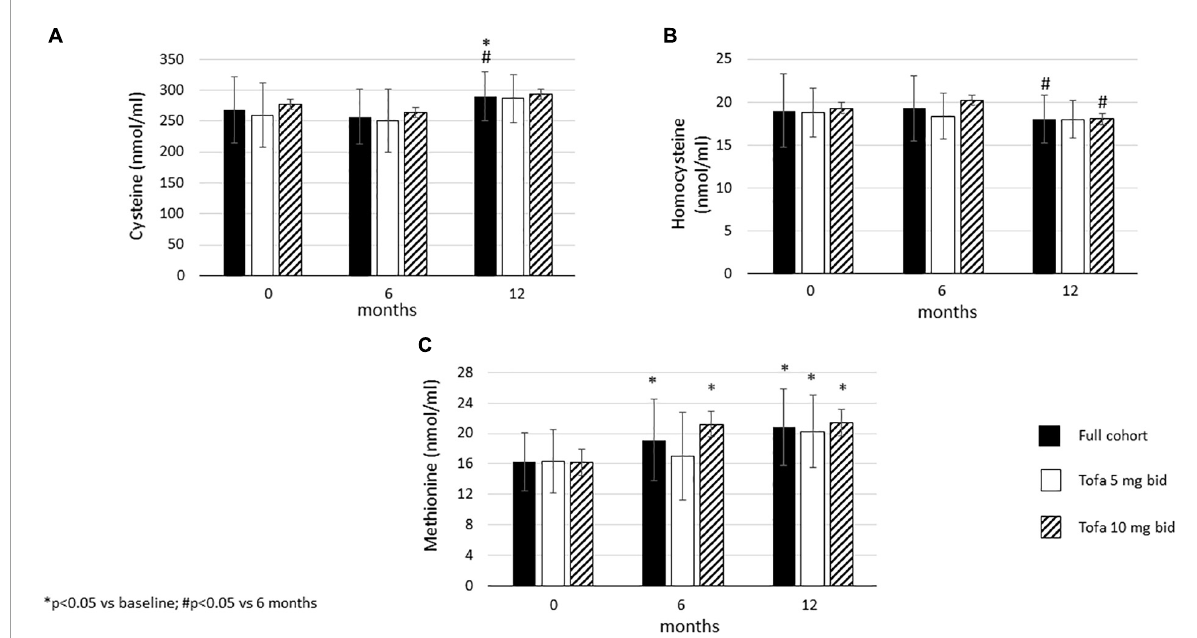
FIGURE5 Effects of one-year tofacitinib therapy on metabolites in the methionine cycle. (A) Cysteine levels increased overtime in the full cohort after 12 months. (B) Homocysteine production decreased in the full cohort and the 10 mg bid subset after 12 months. (C) Methionine levels increased overtime in the full cohort and in the 10 mg bid subset after 6 and 12 months and also in the 5 mg bid subset after 12 months.